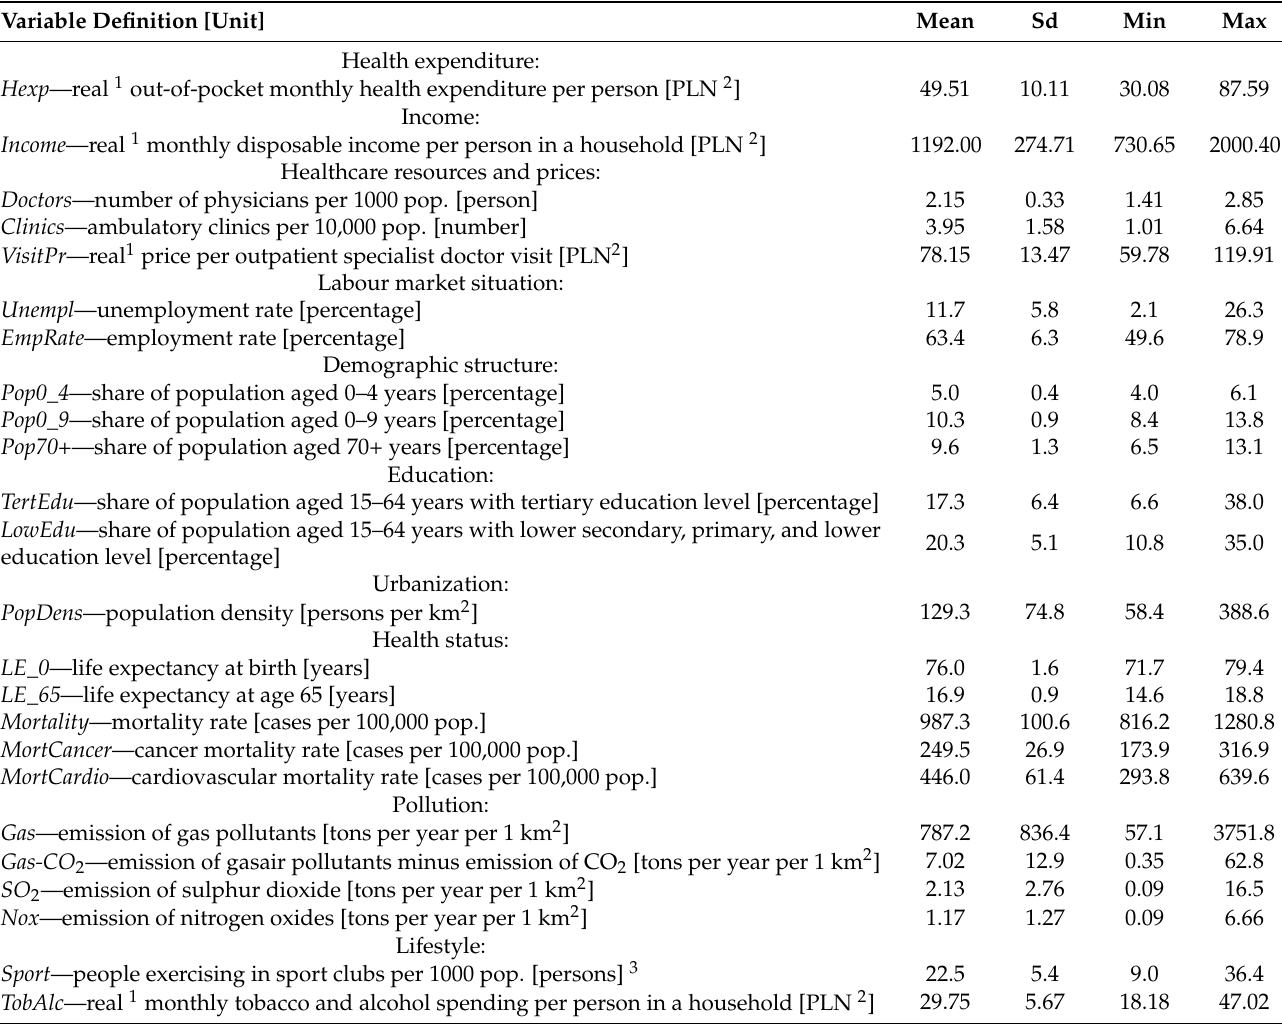
Table 1. Variable definitions and descriptive